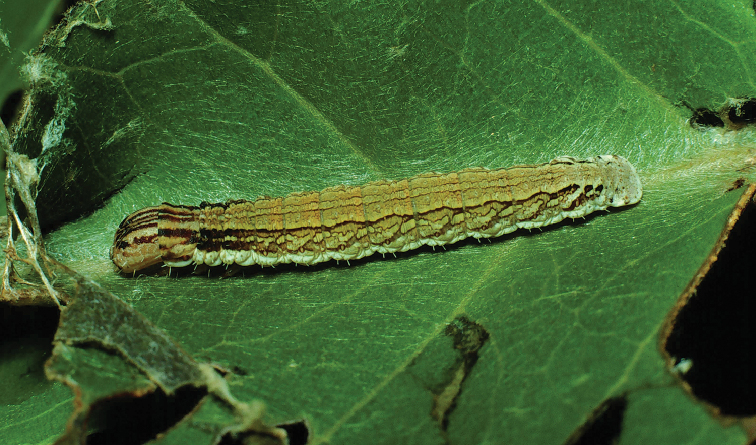
Larva of Citrallarumina, Costa Rica, Guanacaste, Santa Rosa, Cafetal, on Eugeniasalamensis (Myrtaceae), voucher ID: 90-SRNP-1981 [resulting adult female specimen in Fig. 116]. Photo courtesy of D Janzen, used with permission.